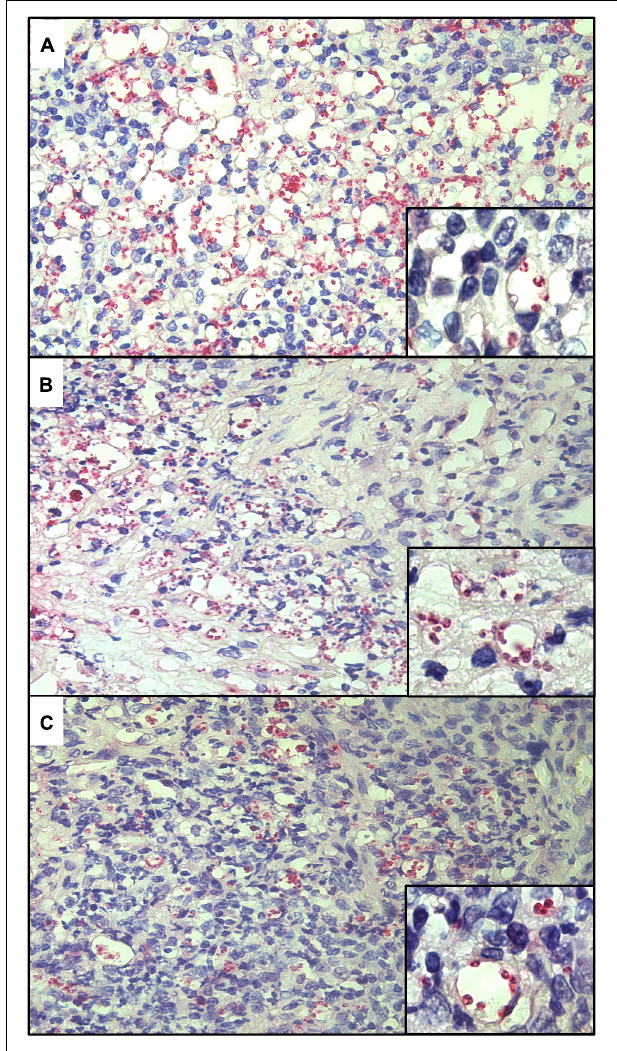
FIGURE 3 | Histological sections of skin lesions from golden hamsters experimentally infected with L. amazonensis (A) , L. braziliensis (B) , and L. guyanensis (C) showing the labeling of amastigote forms by IHC-AP using anti-mTXNPx mAb (IHC-AP, 280 × ). Detail showing amastigote within parasitophorous vacuoles (700 ×